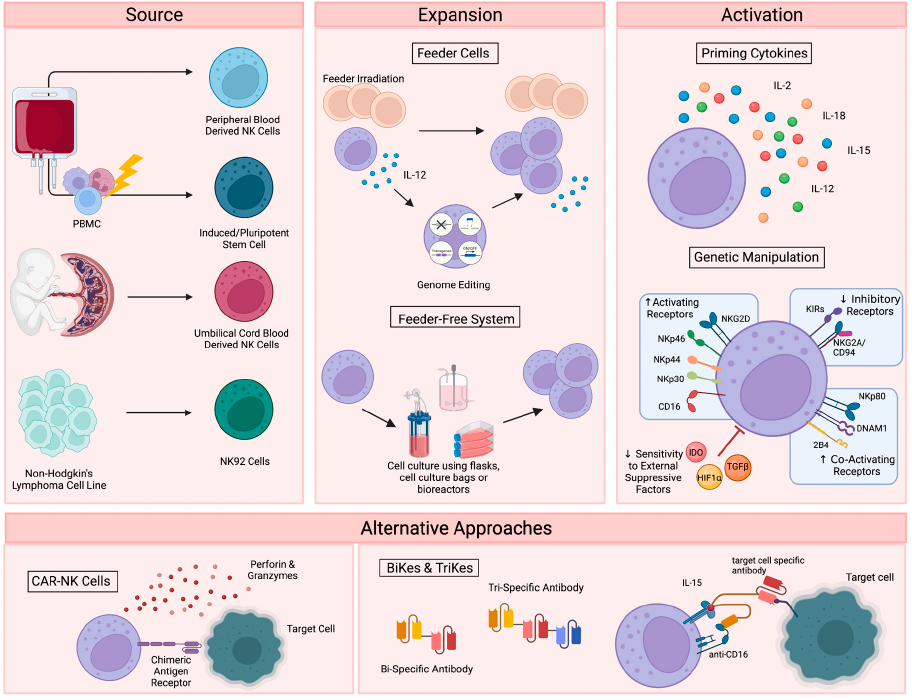
Figure 1. Current NK cell therapies. Schematic showing the current use of NK cell therapies, starting with source, expansion, and activation, then demonstrating the recently developed alternative approaches. Figure created with BioRender.